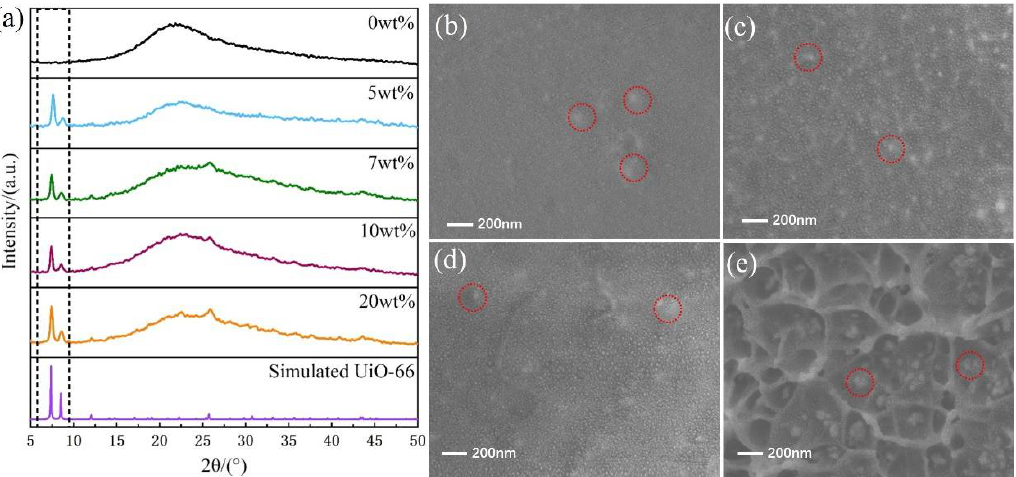
Figure 6. ( a ) XRD patterns of U-C(60)/QPPO with different MOF fillers. ( b – e ) SEM images of U-C(60)/QPPO with different filler loading. (( b ). 5 wt%; ( c ). 7 wt%; ( d ). 10 wt%; ( e ). 20 wt%). U-C(60) in U-C(60)/QPPO was marked by red circle.